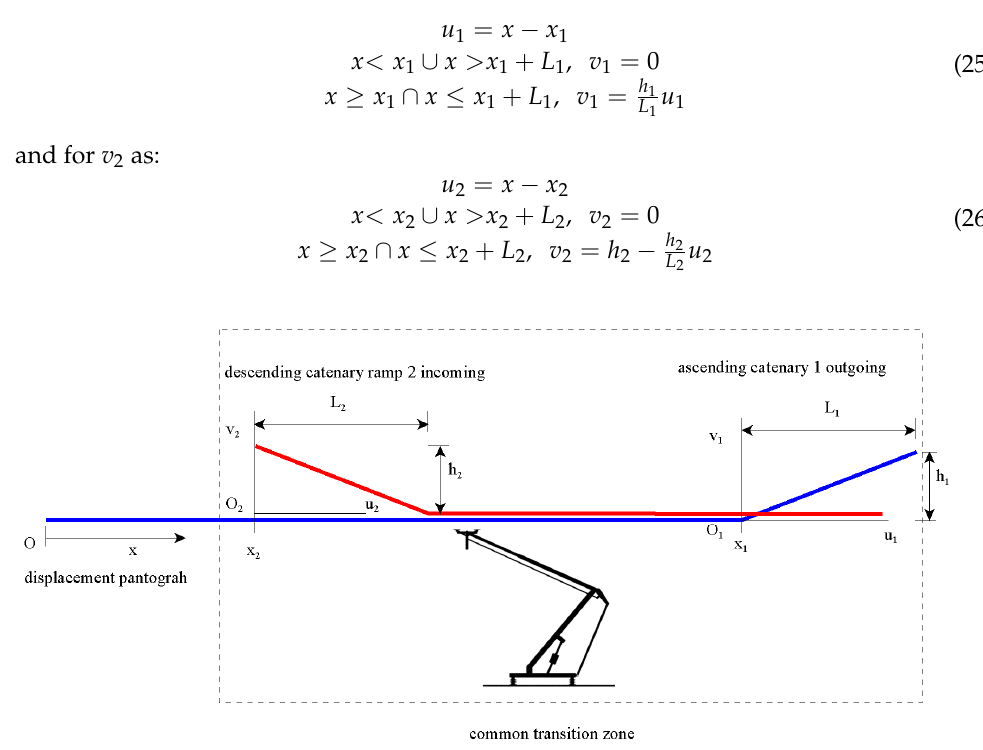
Figure 7. Position correction functions of the contact element for linear